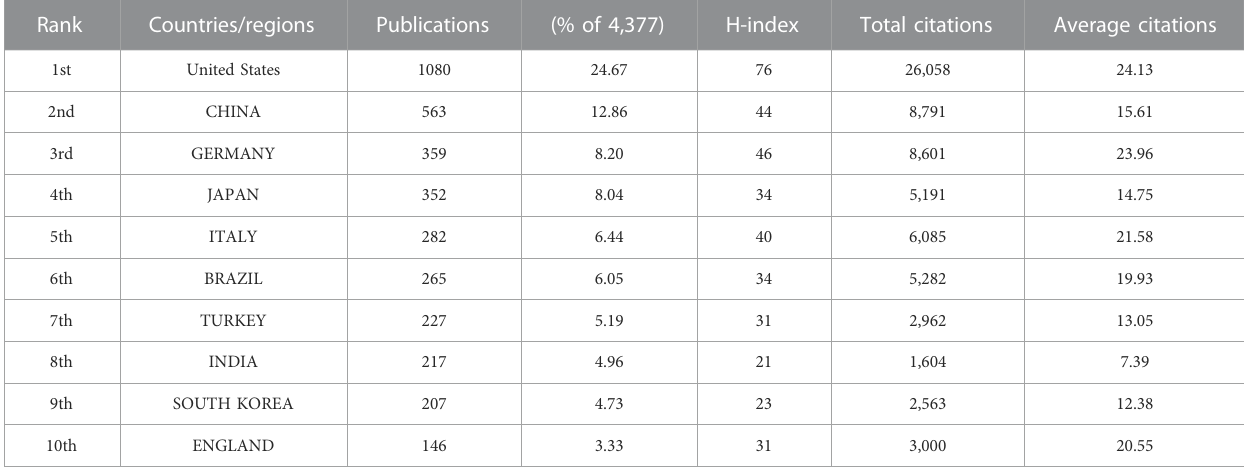
TABLE 1 Top ten countries by publications, H-index, and citations of mandibular defect